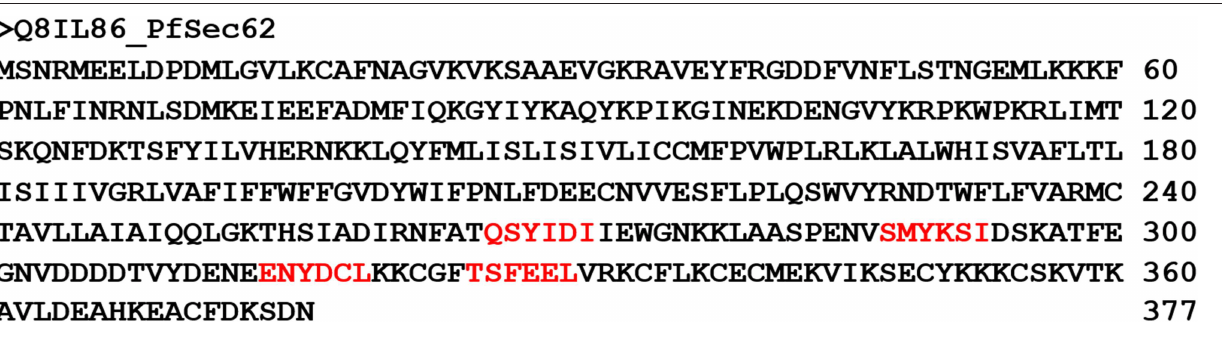
FIGURE 1 | Protein s equence of Pf Sec62 highlighting the four AIM motifs in red, predicted using iLIR web